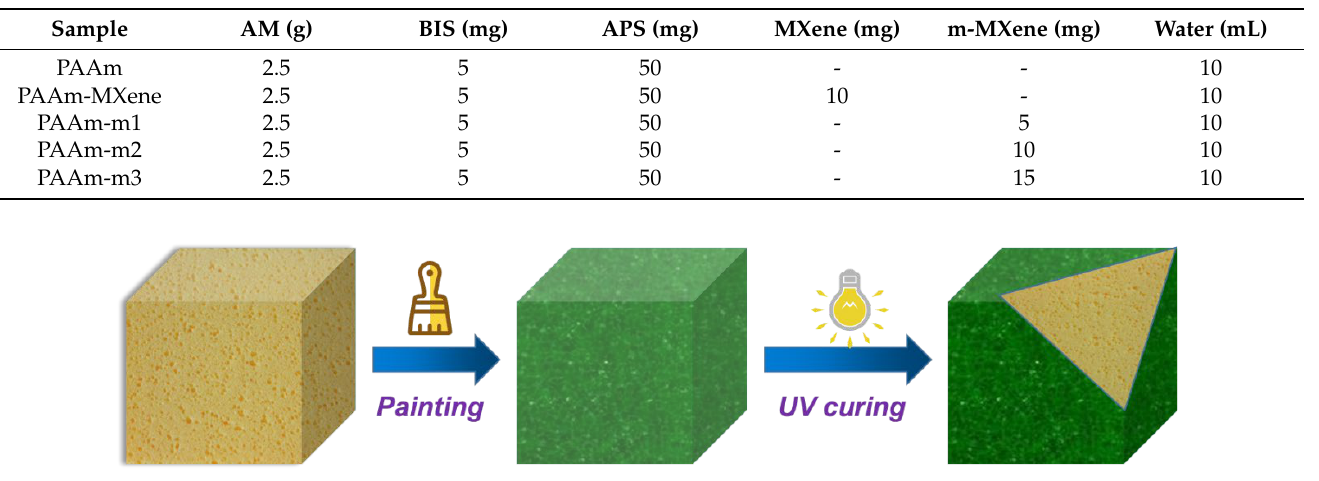
Table 2. Designation and formulations of the hydrogel coating.